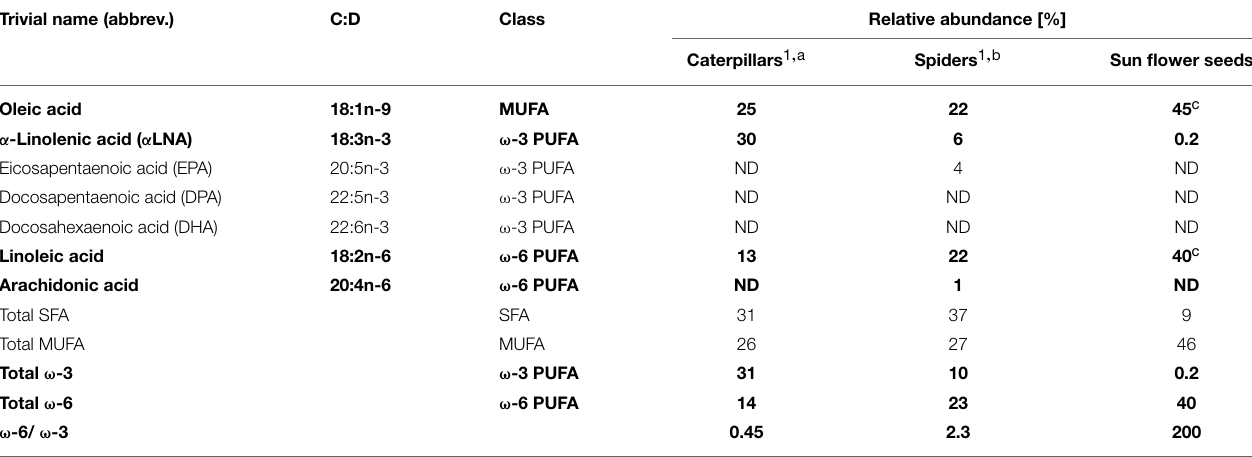
TABLE 1 | Classification and average relative abundance [% of total fatty acid (FA) content] of major fatty acids in common great tit food items. Trivial name